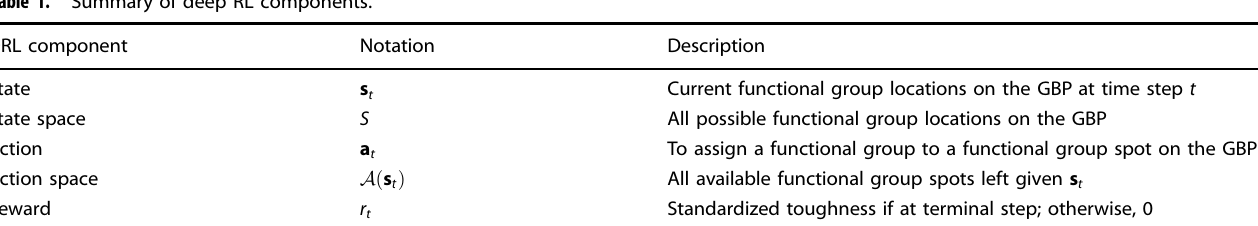
Fig. 2 Deep RL state transition and trajectory. a Illustration of deep RL policy and state transition. b An example full trajectory. Table 1. Summary of deep RL